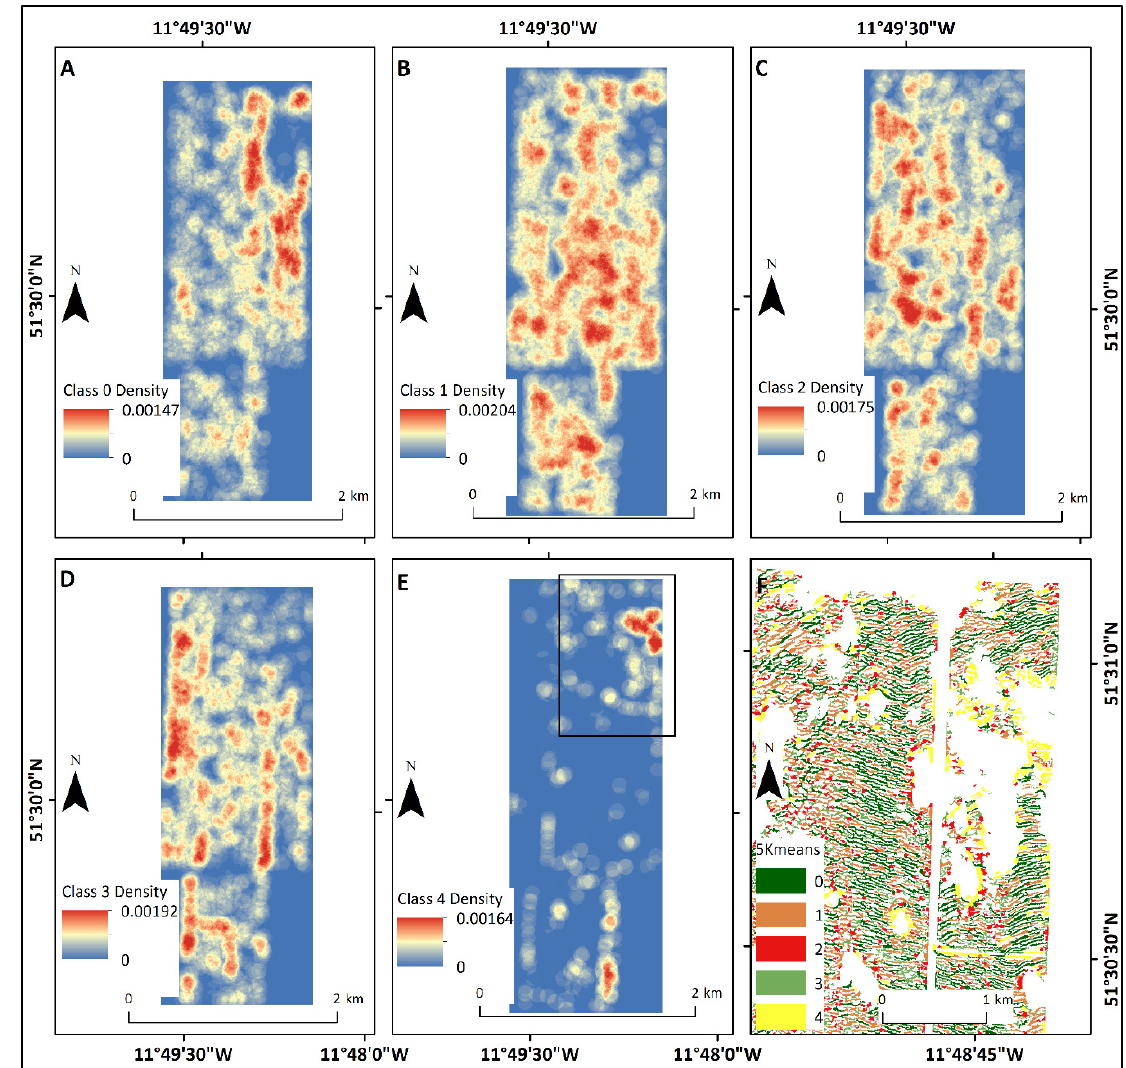
Figure 9. 5 k-mean class density maps for each class: ( A ) class 0, ( B ) class 1, ( C ) class 2, ( D ) class 3, and ( E ) class 4 displaying the extent of ( F ) outlined in black, ( F ) displays the k-means classification for the “crests” in the north-western portion of the study site.